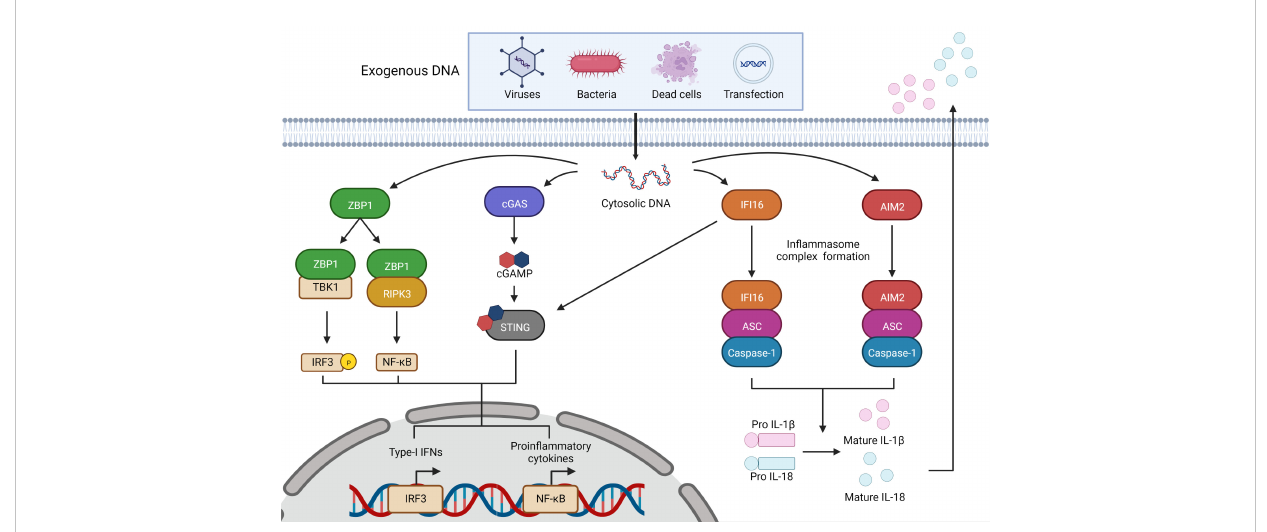
FIGURE 1 Cytosolic DNA sensors and their signaling pathways. Sensing of dsDNA by ZBP1 induces its association with RIPK3 and subsequent activation of NF- k B to elicit pro-in fl ammatory cytokine production, and/or its interaction with TBK1 to induce IRF3 activation and type-I IFN expression. Sensing of dsDNA by cGAS catalyzes the production of cGAMP that activates STING and leads to TBK1 activation that induces IRF3 activation and type-1 IFN expression. IFI16 can directly interact with STING following DNA sensing resulting in NF- k B and IRF3 activation, or can associate with ASC to form an in fl ammasome complex resulting in caspase-1-mediated IL-1 b and IL-18 release. AIM2 sensing of dsDNA also leads to in fl ammasome complex formation with ASC and mature IL-1 b and IL-18 release. This fi gure was created with